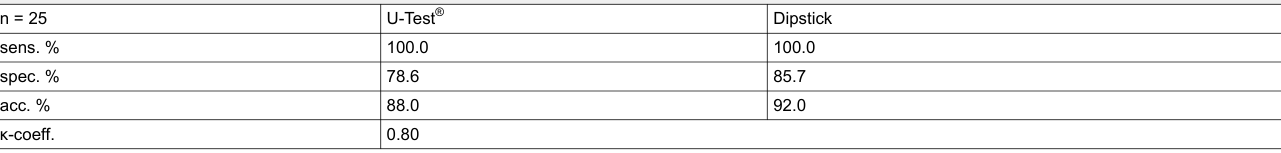
Table 3: Constitution of urine samples evaluated in the in-vitro study by Multistix ® 10 SG (SM), which served as reference method for the comparative evaluation of the performance parameters of U-Test ® (UT) and Combur 10 Test ® (CT). For UT and CT the general interpretation of such values is given as according to the supplier. Nitrite [mg/l] 0.75